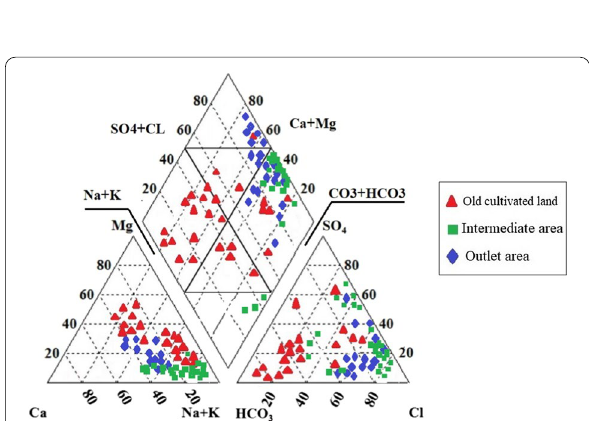
Fig. 9 Piper trilinear diagram representation of groundwater samples in the (red triangle) old cultivated land area, (blue diamond) outlet area and (green square) intermediate area of wadi El-Assiuti